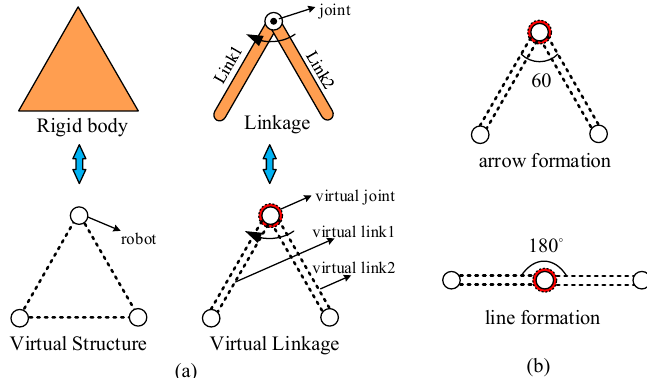
Figure 1. ( a ) Principle of virtual structure and virtual linkage. ( b ) Different formation using a specified virtual linkage.